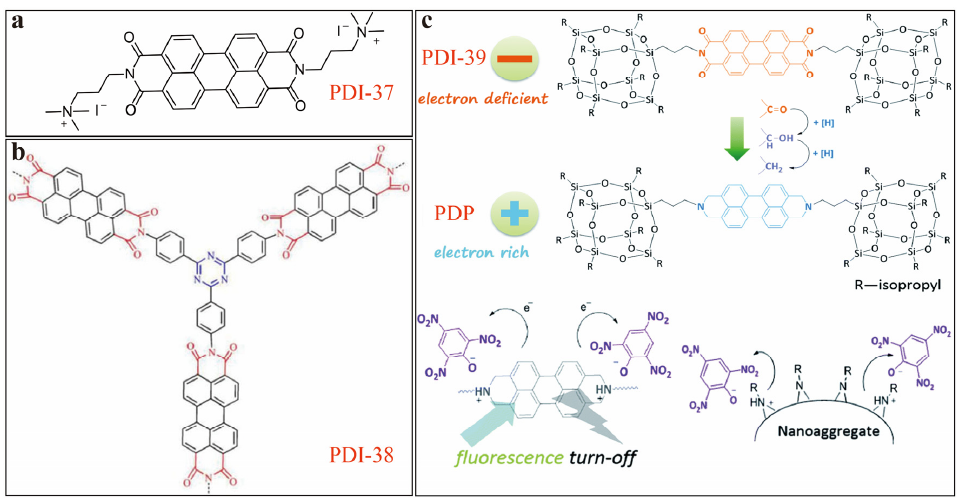
Figure 13. ( a ) Molecular structure of PDI-37. ( b ) Molecular structure of PDI-38. ( c ) Illustration of molecular structures of PDI-39 and PDP, and PA-induced fluorescence quenching mechanisms of PDP in solution and solid state. Adapted and reproduced with permission from [49], copyright 2015 Royal Society of Chemistry.